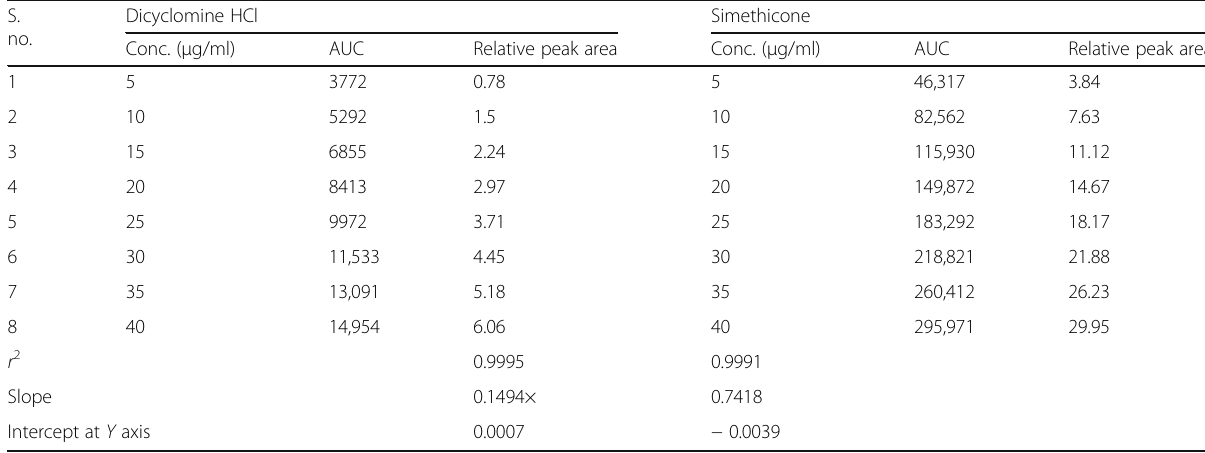
Table 2 Linearity study of Dicyclomine HCl and Simethicone S. no.